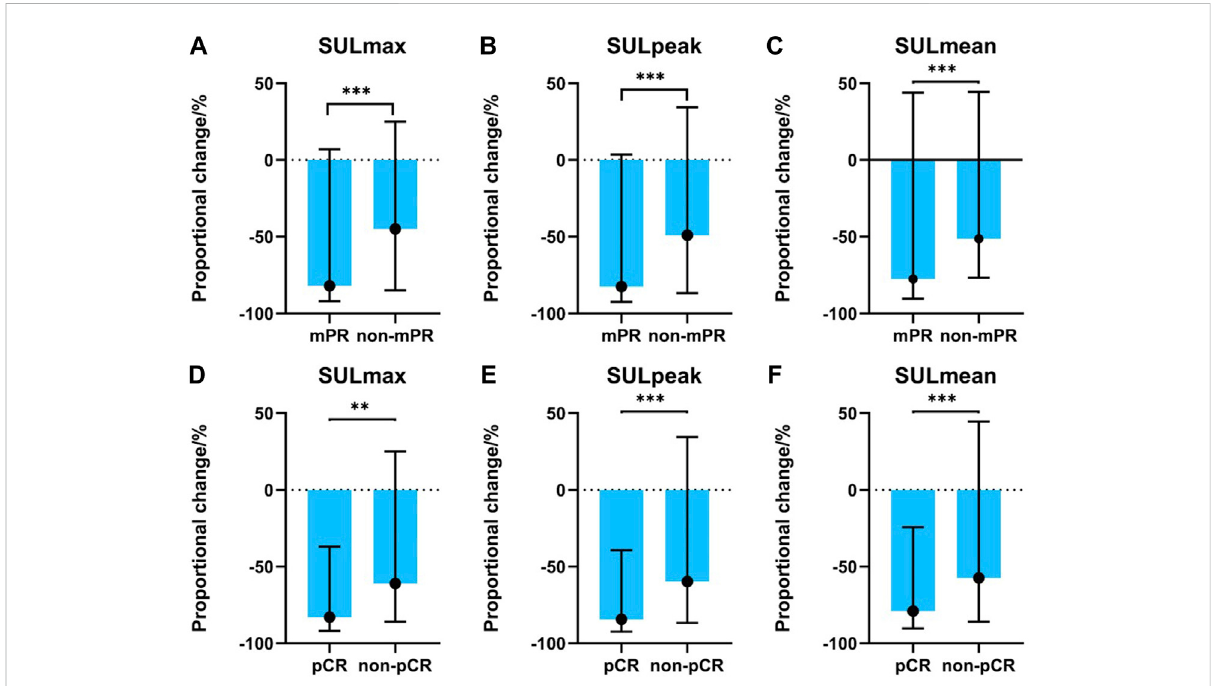
FIGURE 2 Association between PET-related parameters and pathological responses. (A) SULmax between mPR and non-mPR cohorts; (B) SULpeak between mPR and non-mPR cohorts; (C) SULmean between mPR and non-mPR cohorts; (D) SULmax between pCR and non-pCR cohorts; (E) SULpeak between pCR and non-pCR cohorts; (F) SULmean between pCR and non-pCR cohorts.